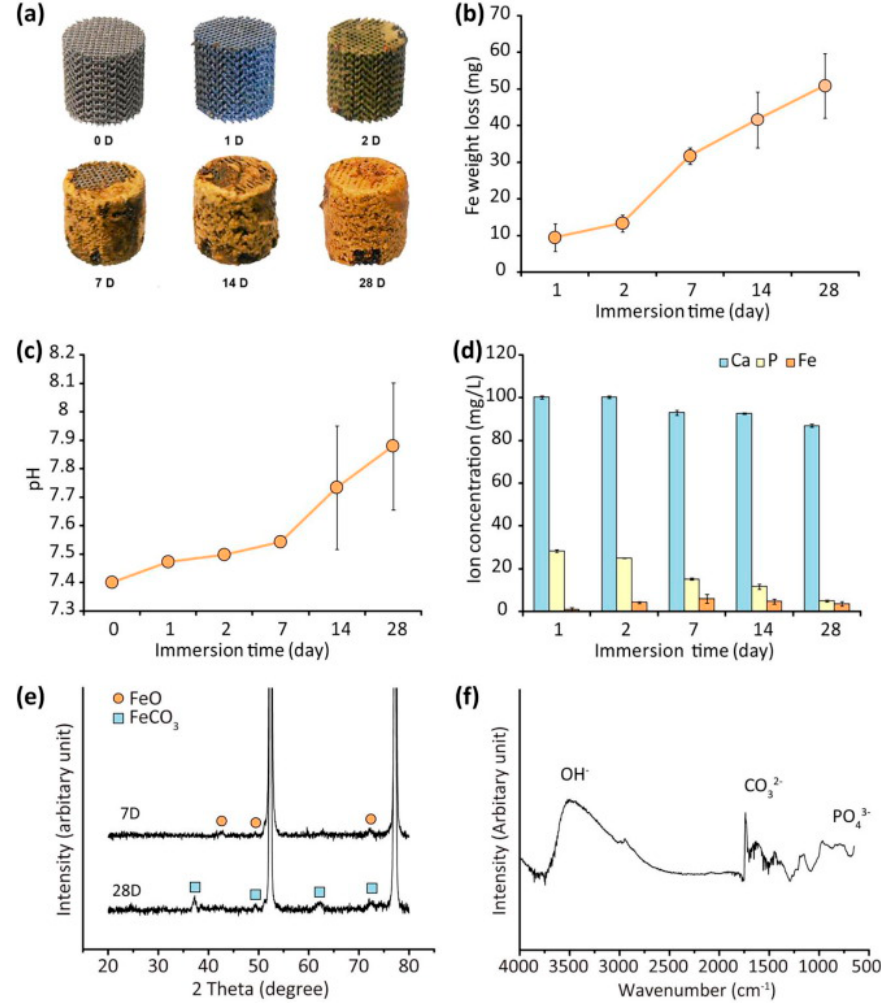
Figure 5. In vitro degradation behavior of iron scaffolds: ( a ) visual inspection of as-degraded scaffolds, ( b ) weight loss, ( c ) pH variation with immersion (the error bar is invisible before day 7 because of a small deviation), ( d ) ion concentration variation with immersion time, ( e ) XRD analysis, and ( f ) FTIR analysis of degradation products scaffolds. Reprinted from Reference [50] with permission from Elsevier.